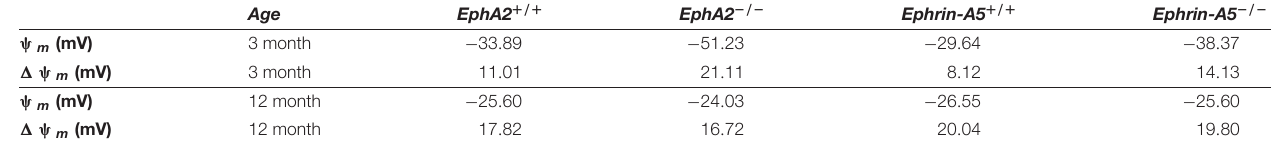
FIGURE 8 | Intracellular voltage ( ψ i ) in lenses from 3- and 12-month-old control, EphA2 − / − and ephrin-A5 − / − mice. (A) Intracellular voltage in lenses from 3-month-old EphA2 + / + (black squares with solid fit line), EphA2 − / − (open squares with dashed fit line), ephrin-A5 + / + (black circles with solid fit line), and ephrin-A5 − / − (open circles with dashed fit line) lenses as a function of distance from lens center ( r / a ), where r (cm) is actual distance and a (cm) is lens radius. KO lenses were hyperpolarized when compared to controls ( n ≥ 6). (B) Intracellular voltage in lenses from 12-month-old EphA2 + / + (black squares with solid fit line), EphA2 − / − (open squares with dashed fit line), ephrin-A5 + / + (black circles with solid fit line), and ephrin-A5 − / − (open circles with dashed fit line) lenses as a function of distance from the lens center. There are no significant differences in intracellular voltage between control and KO lenses ( n ≥ 6). TABLE 2 | Surface resting membrane voltage ( ψ m ) and the change in voltage between the surface and center ( (cid:49) ψ m ) in four types of lenses at two